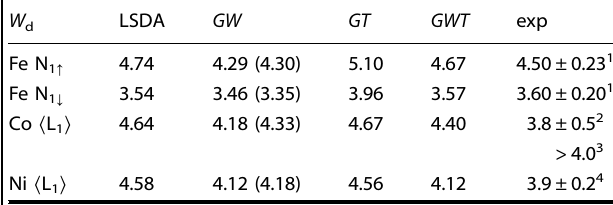
Table 2. d bandwidths (in eV) for bcc Fe, fcc Co, and fcc Ni obtained from LSDA, GW , GT , and GWT and compared with experimental